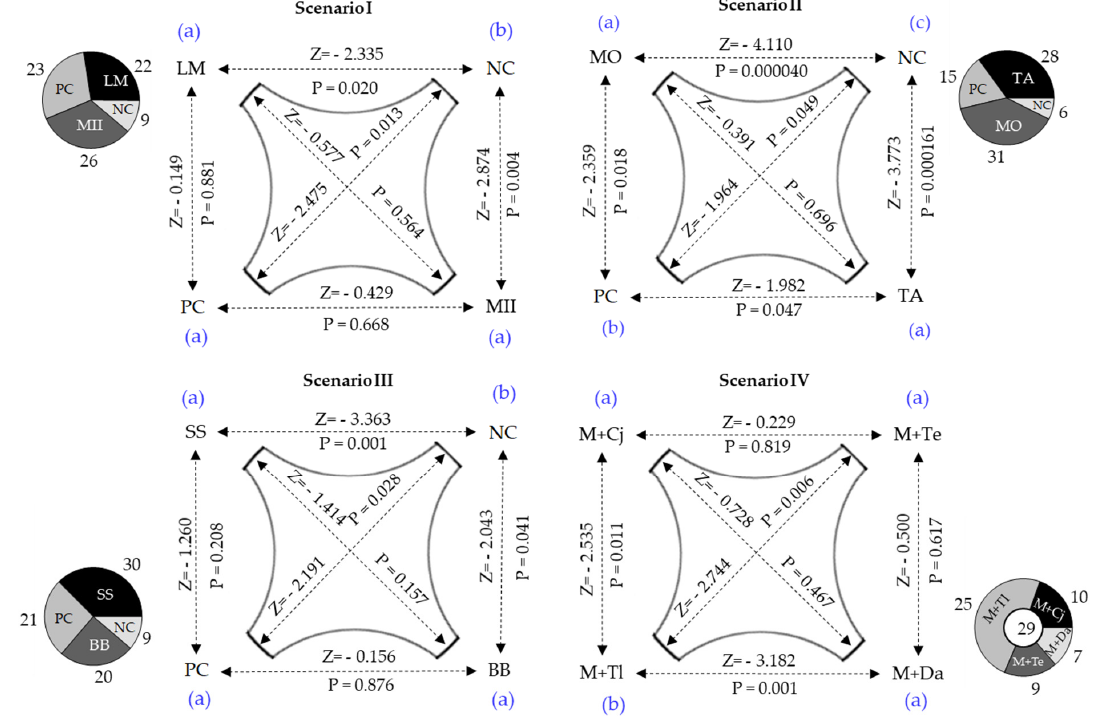
Figure 5. Behavioral responses of attraction (Scenarios I, II and III) and repulsion (scenario IV) of S. frugiperda larvae (L3) in presence of potential attractive [LM = L. multiflorum, MII = B. hybrid cv. Mulato